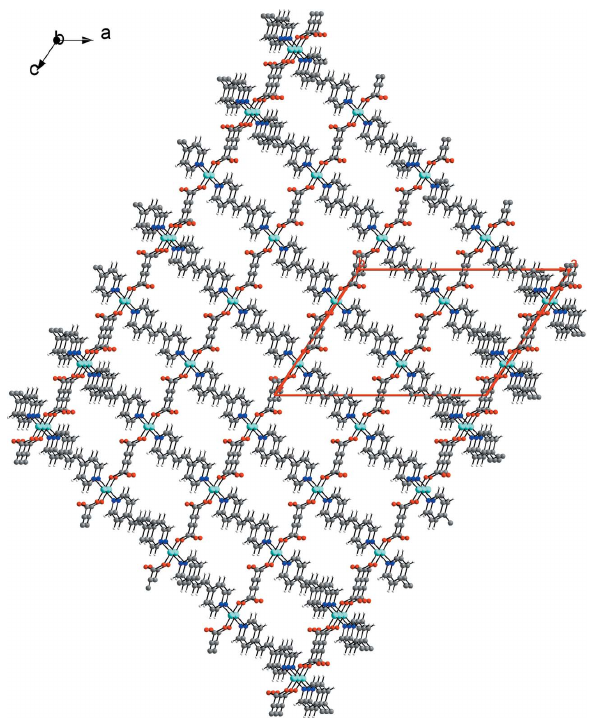
Figure 2 Three-dimensional network viewed along the b axis. Water solvate molecules are omitted for clarity.